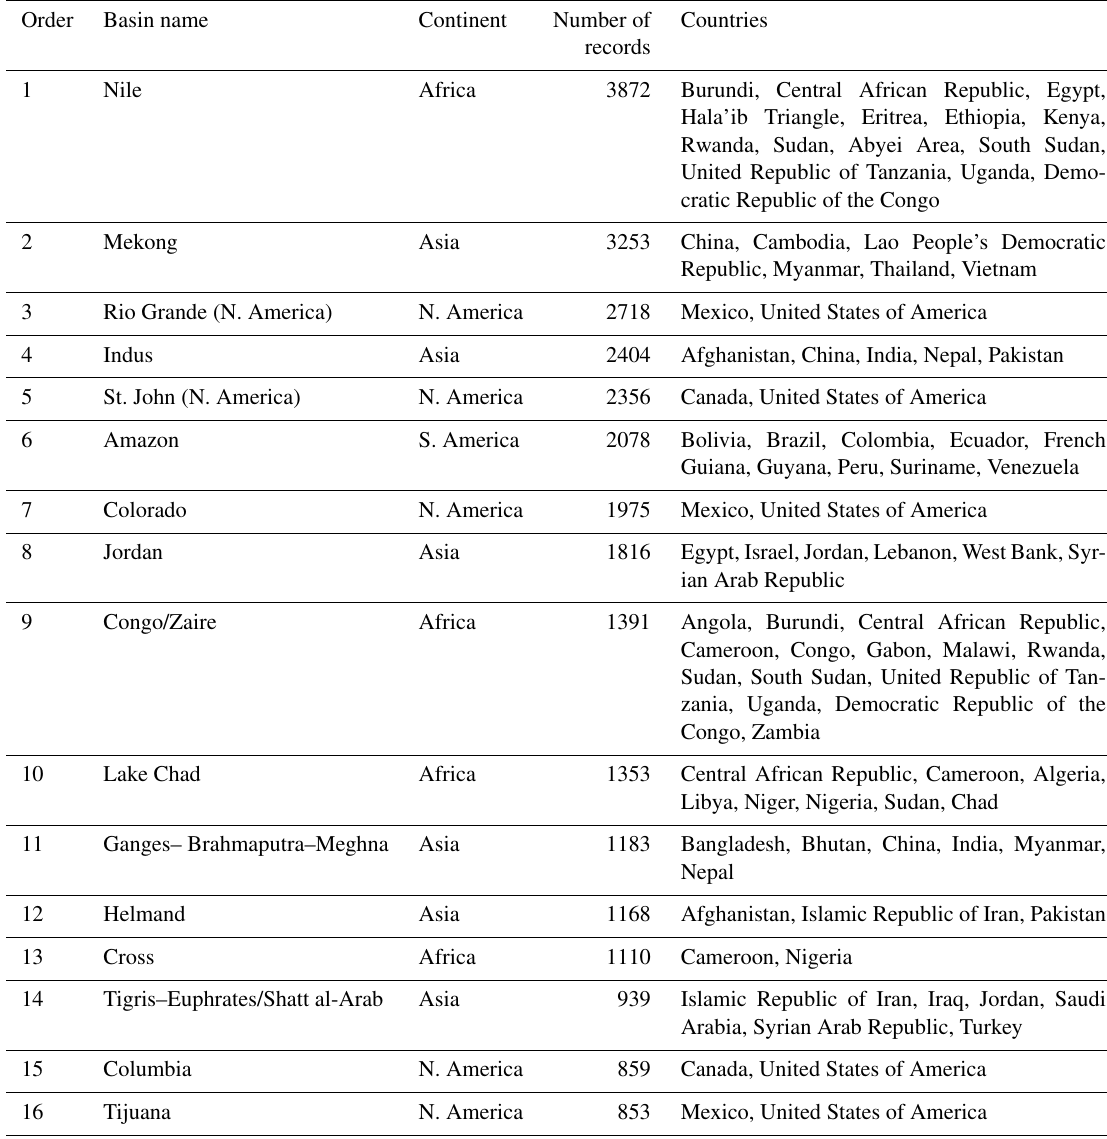
Table 5. 16 Most-discussed basins with more than 850